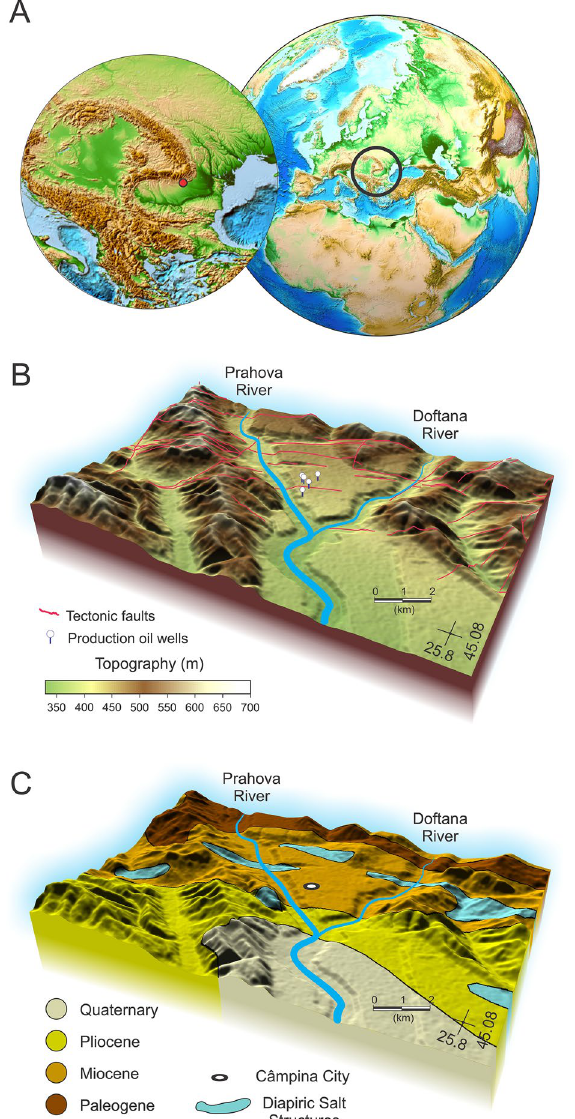
Figure 1. ( A ) Global topography/bathymetry maps showing the location of the regional study area (black circle). Red dot in the left-hand inset marks the position of the study area in the East Carpathians Bend zone. Maps were created based on ETOPO1 Global Relief Model dataset from ref. 32 and generated with the open- source software ParaView (http:// www. parav iew. org) version 5.0.1, licensed under the CC BY 4.0 license (https:// creat iveco mmons. org/ licen ses/ by/4. 0/). ( B ) Color-shaded 3-D view of the topography study area. Red curves draped over the shaded relief represent tectonic faults 33 . White round markers show the location of several production oil wells located in the vicinity of the Prahova and Doftana rives confluence. ( C ) Color- shaded 3-D view of the simplified geological map of the Diapir Fold Zone draped over the topography 22,34